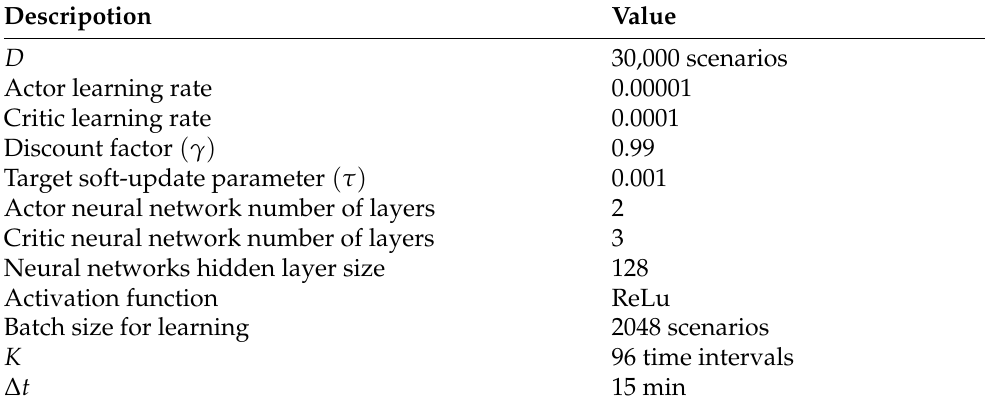
Table 2. Training parameters for Algorithm